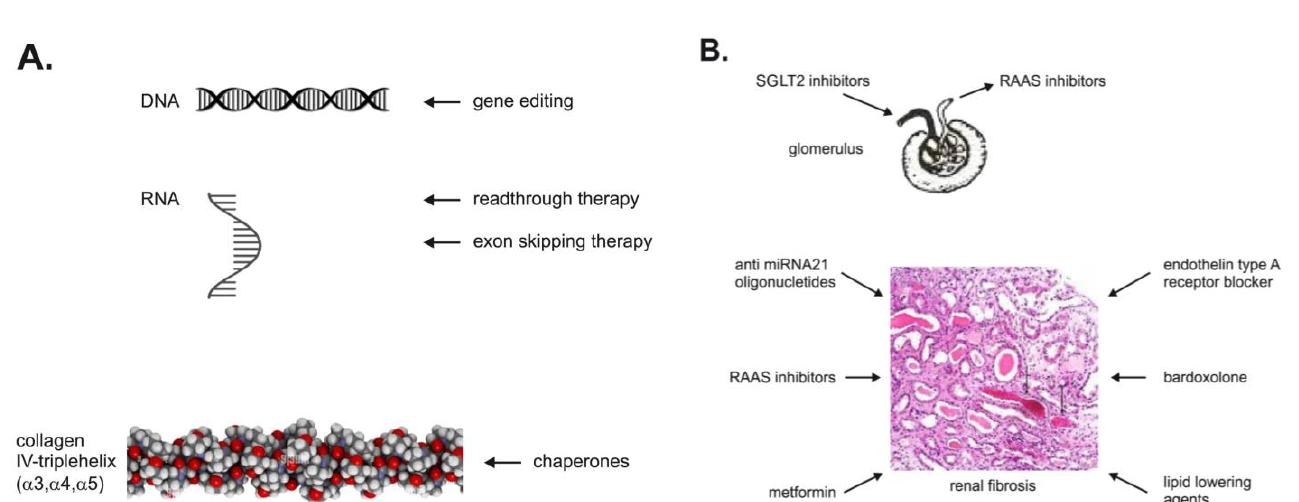
Figure 1. ( A ). Therapeutic targets in AS. Specific therapy is on the level of DNA, RNA, and protein. ( B ). The remaining drugs on the level of glomeruli and tubulointerstitium are unspecific. 5. RAAS (Renin-Angiotensin-Aldosterone System) Inhibition